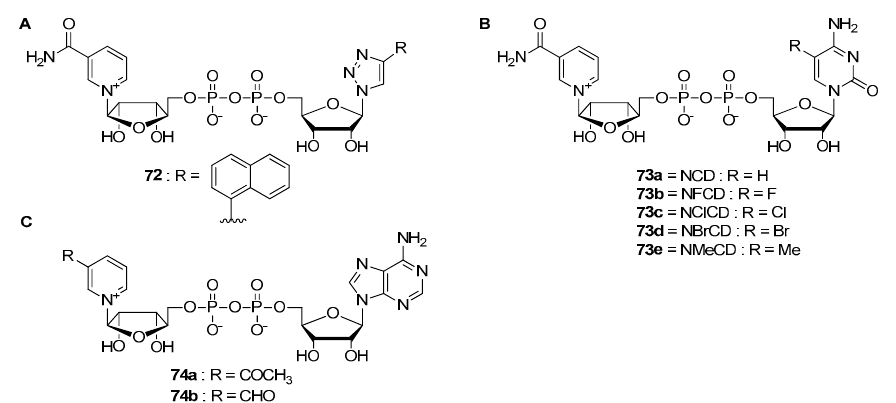
Figure 18. NAD + analogs developed as cofactors for orthogonal redox systems. A ) Triazole